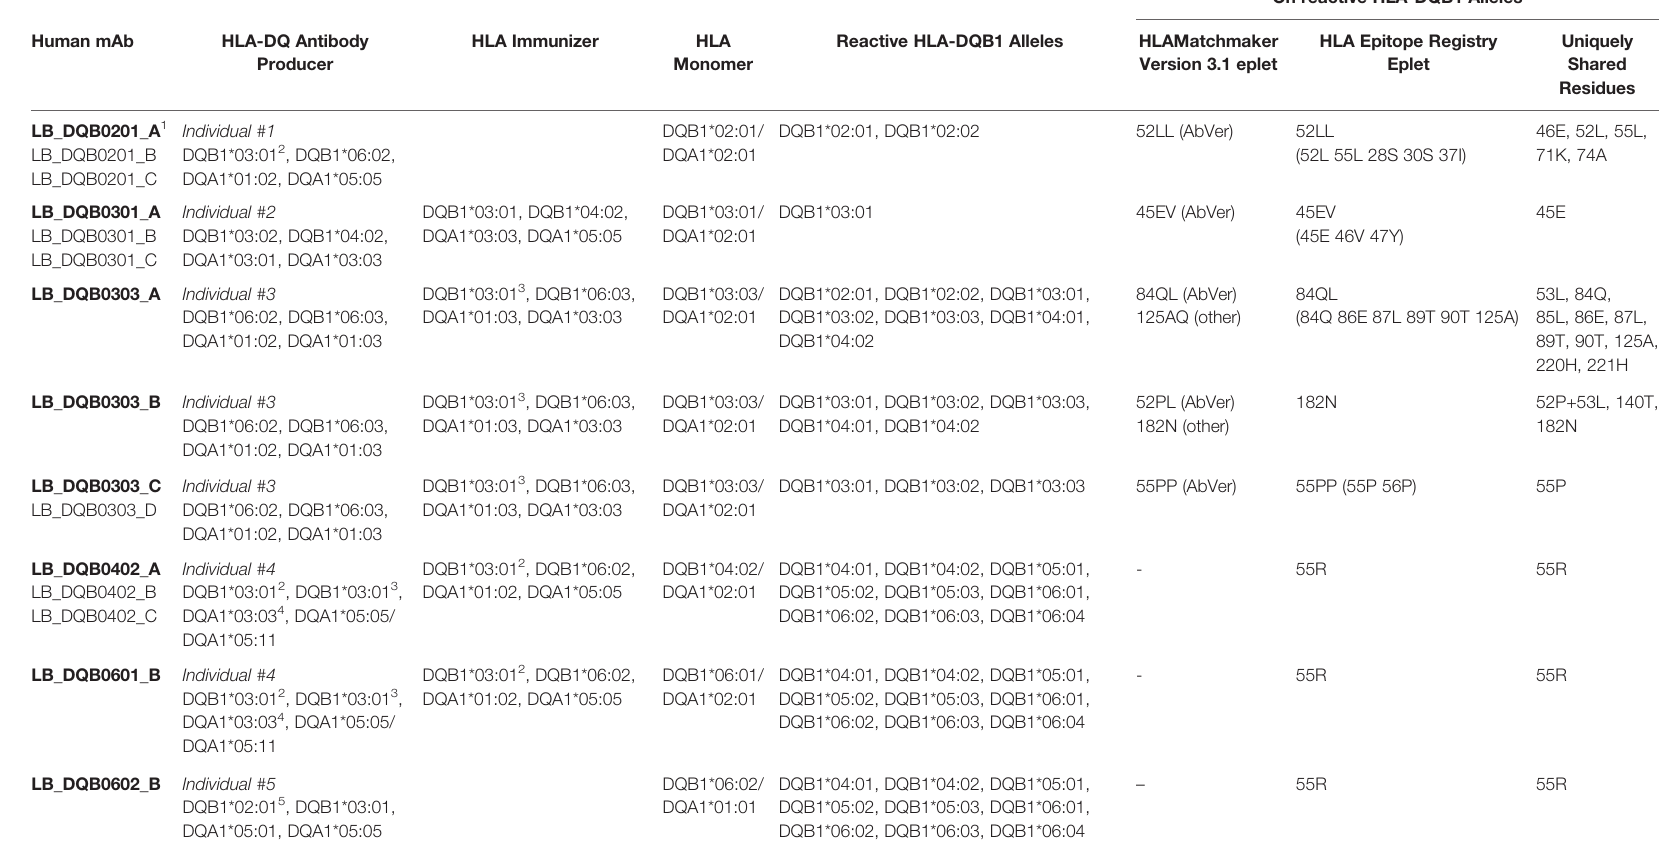
On reactive HLA-DQB1 Alleles